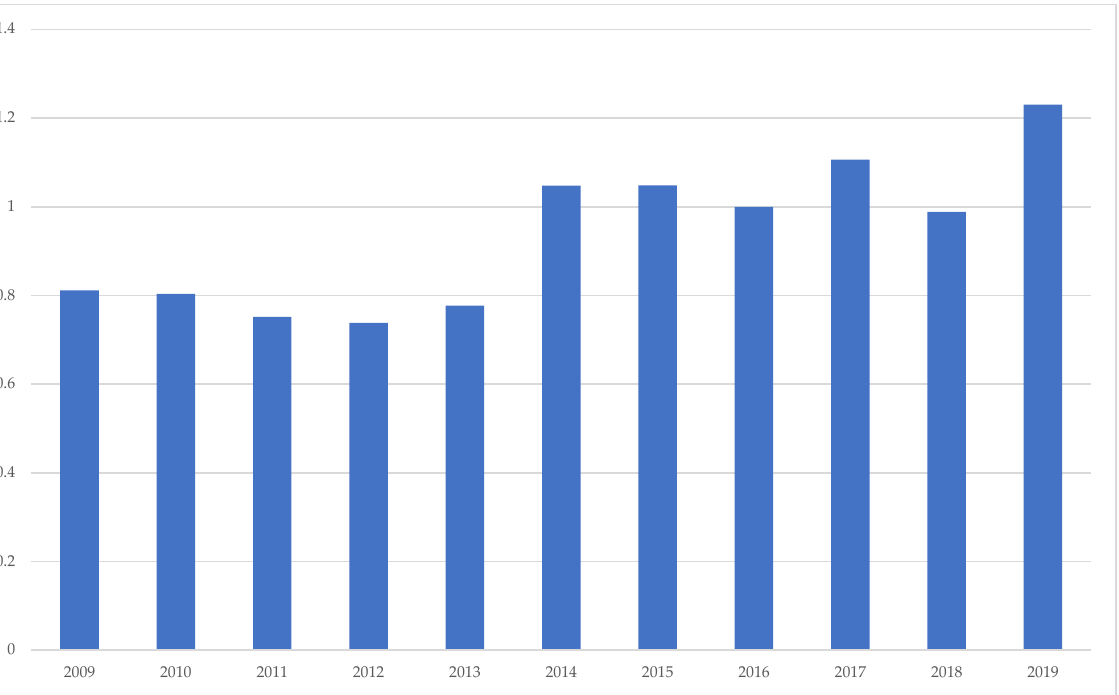
Figure 3. The trend of U.S. sweet potato prices over the years ($/kg).